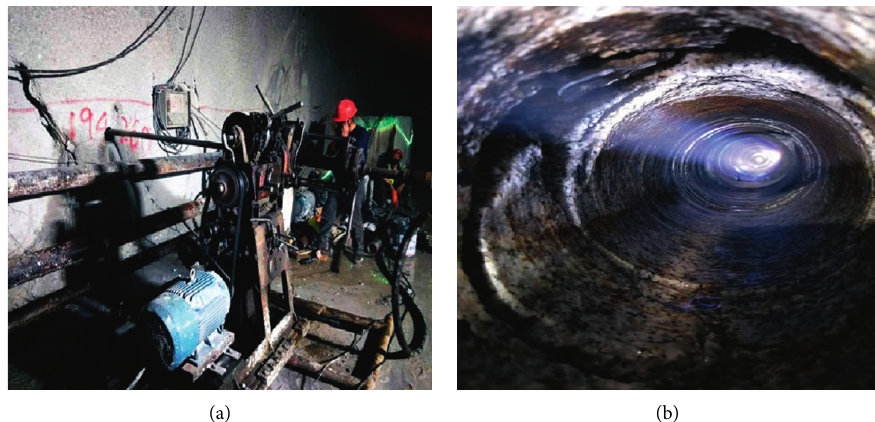
Figure 1: The large hole with a diameter of 130 mm. (a) The large hole drilling process. (b) The appearance of the large hole.